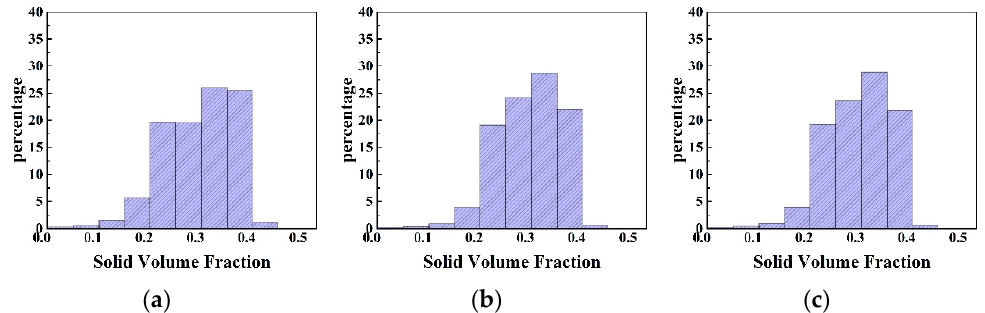
Figure 19. Histogram of solid distribution for DRFTBI with different connection strap length. ( a ) 1.1 Hs; ( b ) 1.2 Hs; ( c ) 1.3 Hs. (Rotational speed: 120 rpm; solid loading: 30%.)